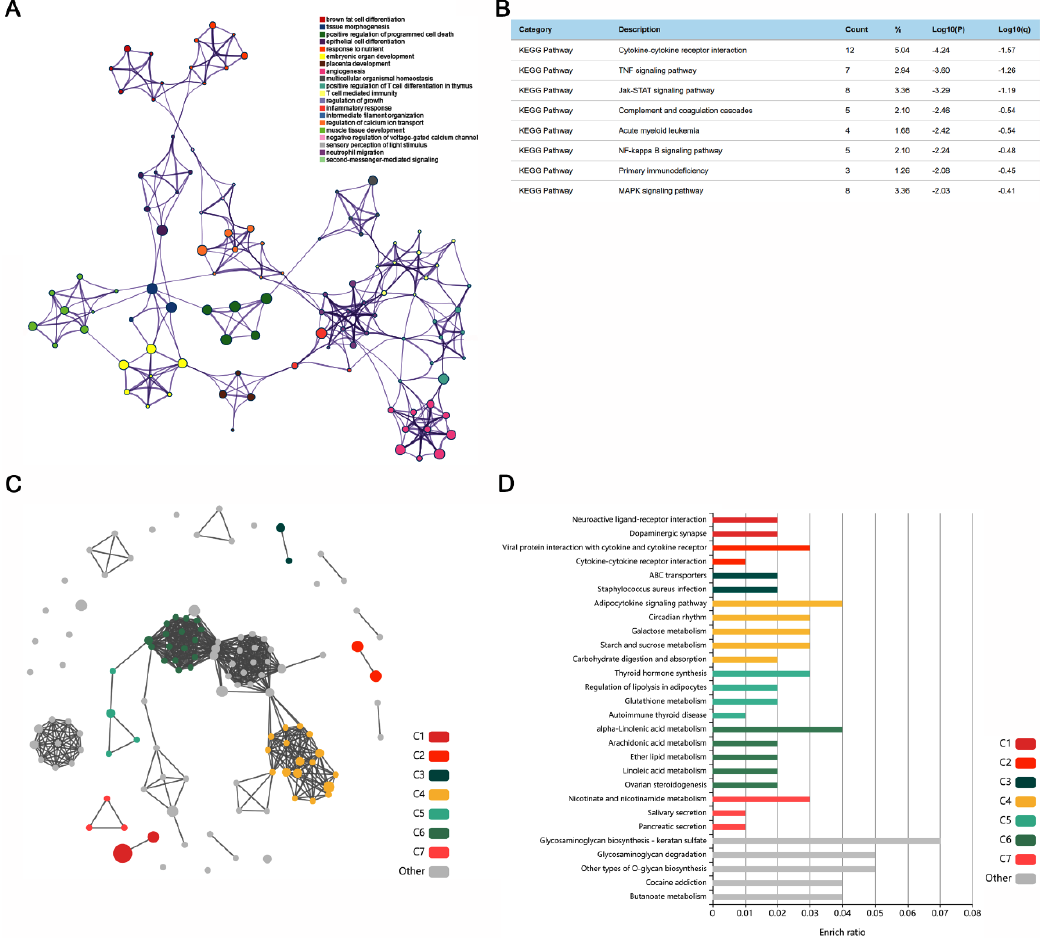
Figure 4. The GO network analysis and KEGG enrichment analysis on DEGs of the PTZ group and CBD group. ( A ) The GO network in the PTZ group. ( B ) The KEGG pathway analysis results in the PTZ group. ( C ) The network analysis on the KEGG signaling pathway by KOBAS. ( D ) The KEGG pathway analysis results in the CBD group.